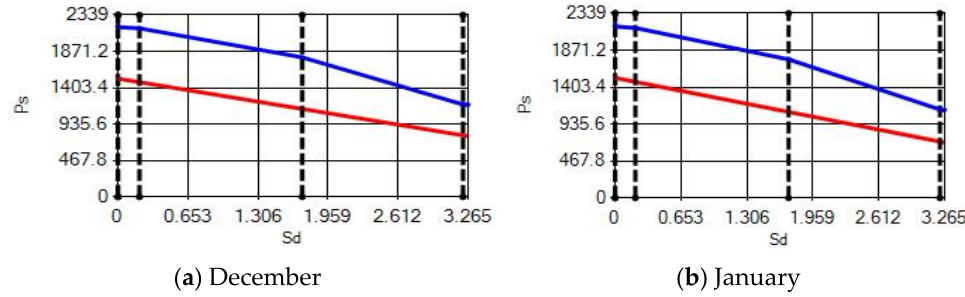
Figure 22. Condensation and evaporation amount chart for the building elements of the pumice external wall for the 1st zone for ( a ) December and ( b ) January.